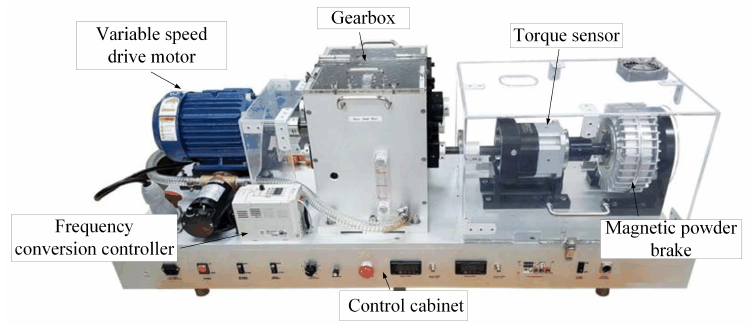
Figure 13. Rotating machinery vibration analysis and fault diagnosis experimental platform XZZZ-1.